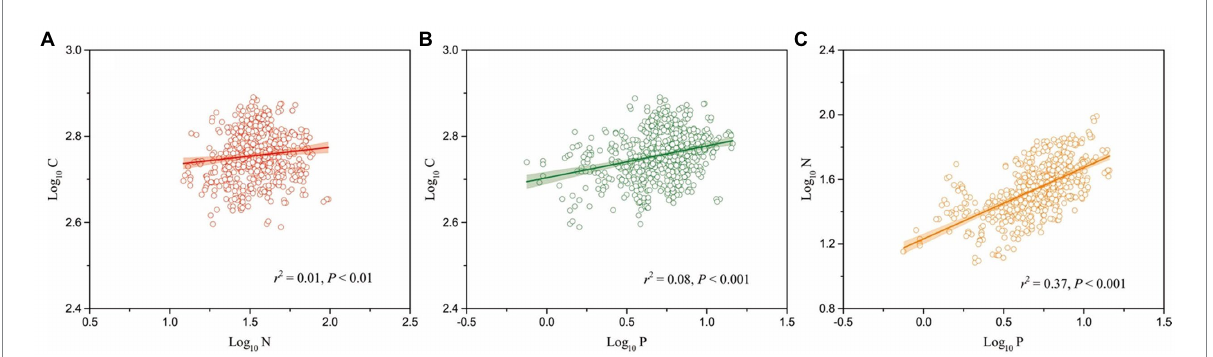
FIGURE 4 Relationships of seed carbon and nitrogen (A) , carbon and phosphorus (B) , nitrogen and phosphorus (C) concentrations for all 253 herbaceous species on the eastern Tibetan